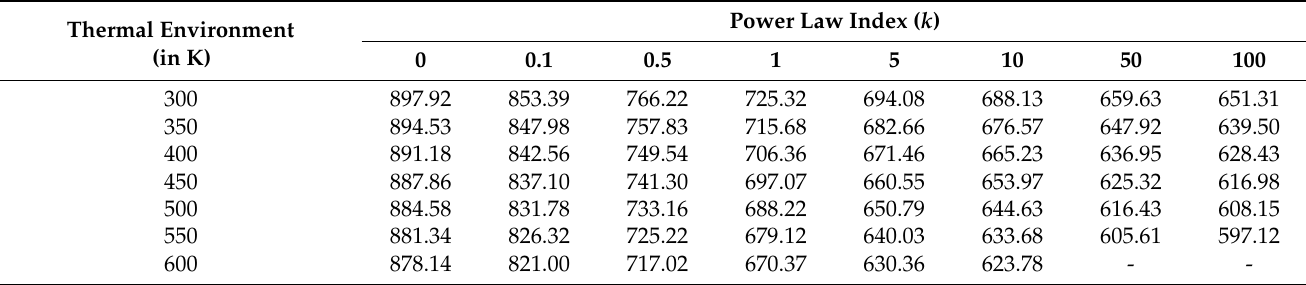
Table 7. Effect of a uniform thermal field on critical buckling temperatures (in K) of a Ti-6Al- 4V/silicon carbide FGM shell for different material composition in re-entry vehicle nose structures.